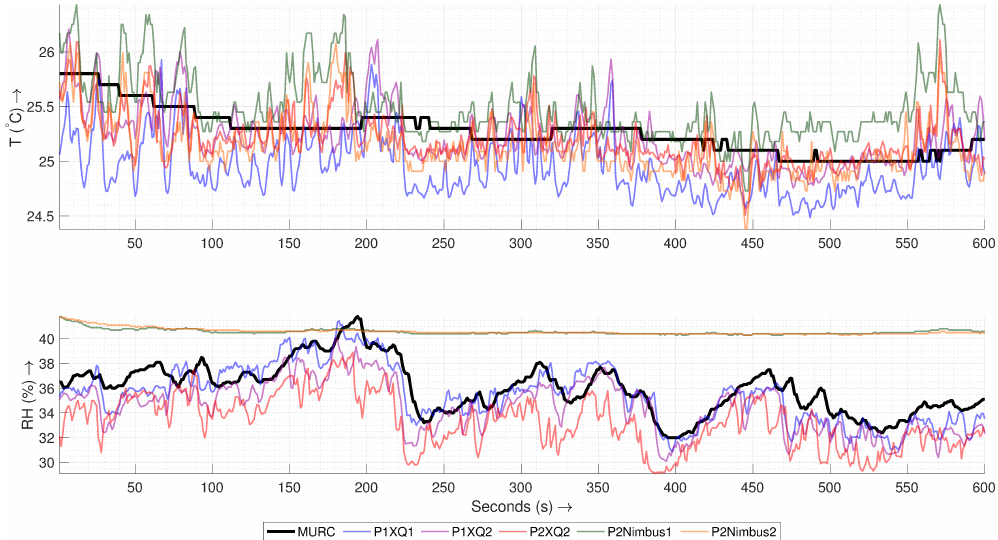
Figure 7. The Temperature (T) and Humidity (RH) time series of the MURC tower and other sensor readings for the 10 min of hover of the UAS at the MURC tower altitude (15.2 m): Only the data from MURC is filtered and corrected for sensor